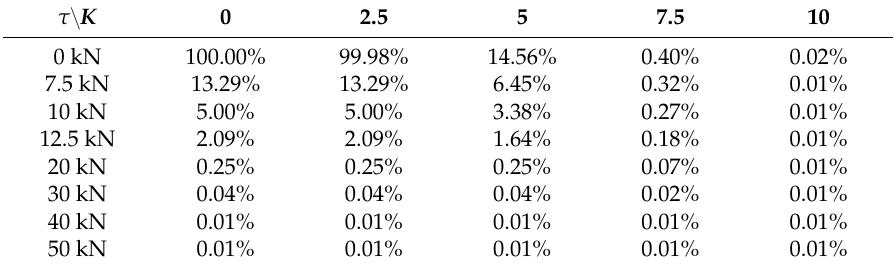
Table 5. Example of the percentage of occurrences of SWMTF datasets considered as containing peak mooring loads on line 1 for different values of τ and K. The joint percentage of occurrences (JPOs) of the τ z K combinations corresponding to the numbers in italics have been plotted in Figure